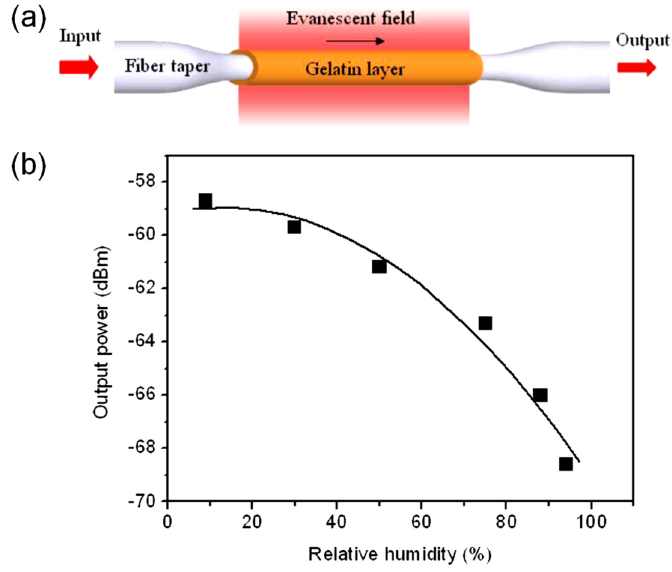
Figure 12. Point sensor. ( a ) Conceptual design of the sensor head. ( b ) Relationship between output power and RH. Adapted with permission from ref. [50]. Copyright 2008 OSA